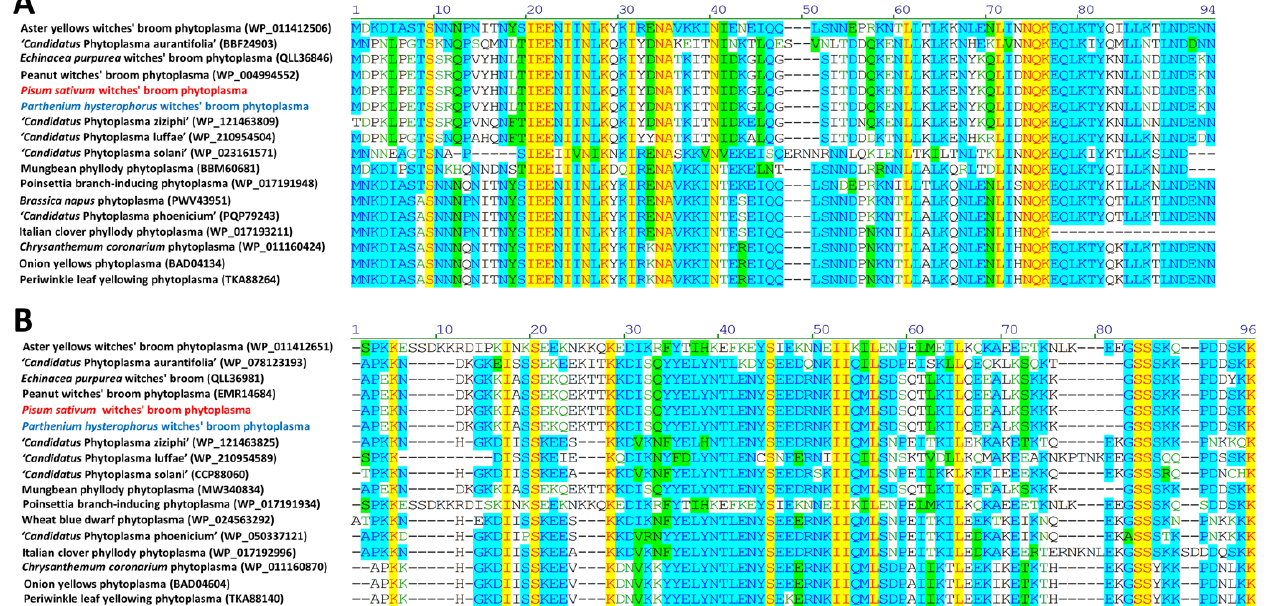
Figure 7. Sequence comparison of effectors responsible for the phyllody and virescence symptoms associated with phytoplasma diseases. Multiple sequence alignment of PHYL1/SAP54 ( A ) and SAP11 ( B ) homologues were generated using AlignX from Vector NTI without signal peptide. Identical residues are shaded in yellow; conservative residues are shaded in blue; blocks of similar residues are shaded in green; weakly similar residues are in green font; and non-similar residues are in black font.